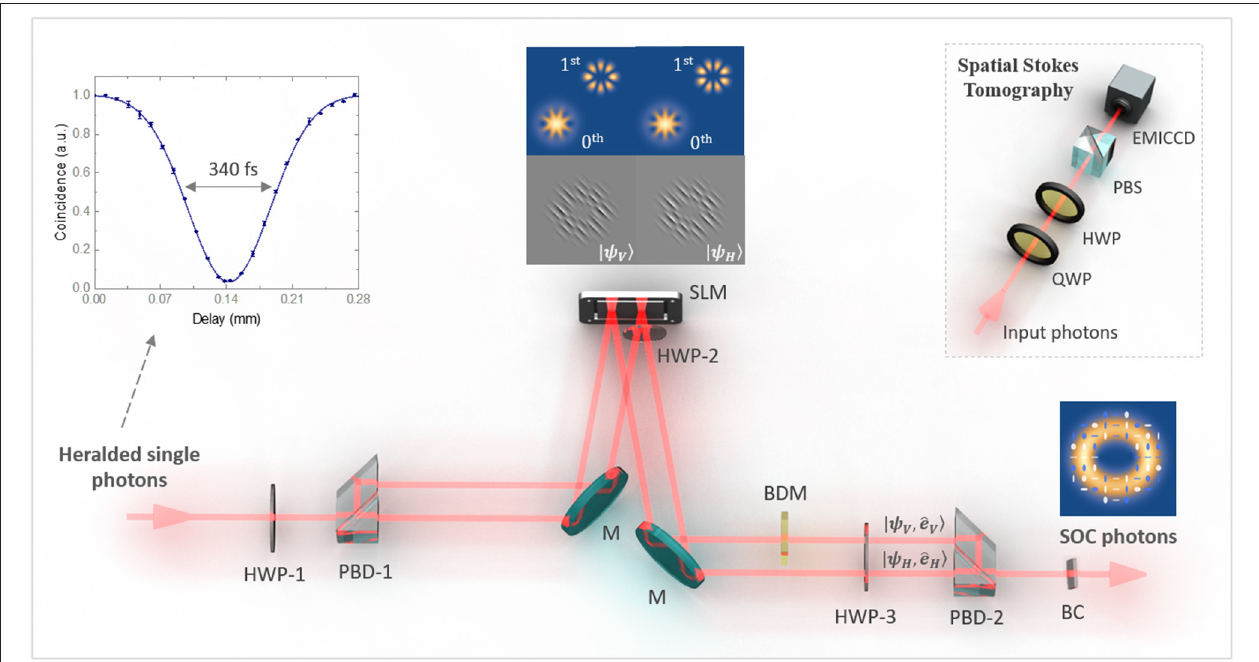
FIGURE 1 | Schematic representation of the experimental setup, where the key components include the polarizing beam displacing prism (PBD), a spatial light modulator (SLM), half-wave plates (HWP), a beam displacement module (BDM), mirrors (M), and a birefringence crystal (BC). The upper-left inset shows the HOM dip of two-photon pairs and the upper-right one shows the setup for the spatial Stokes